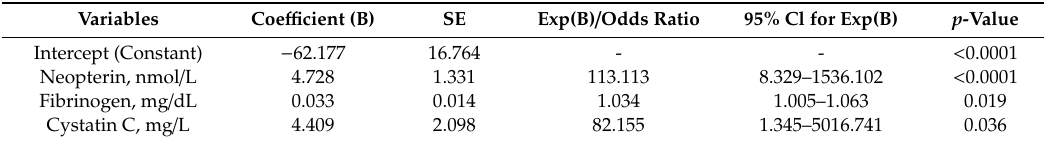
Table 6. Multivariable logistic regression model for PAD